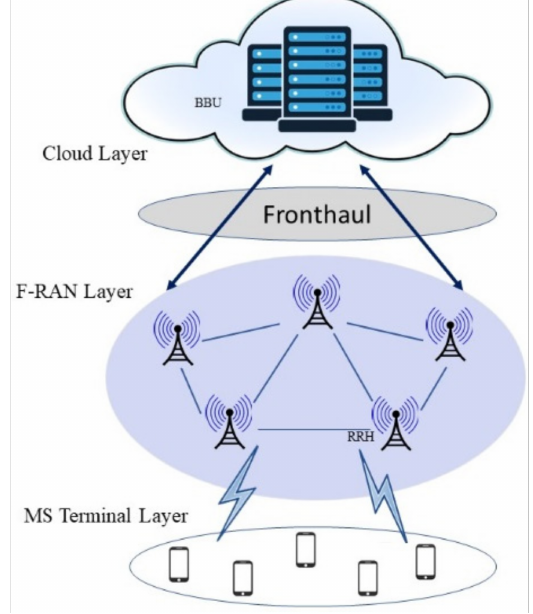
Figure 1. F-RAN Architecture for mmWave NR